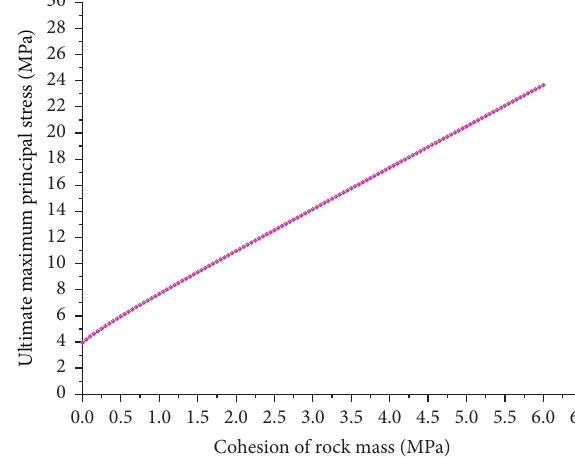
Figure 10: The change of the maximum bearing capacity with cohesion of rock